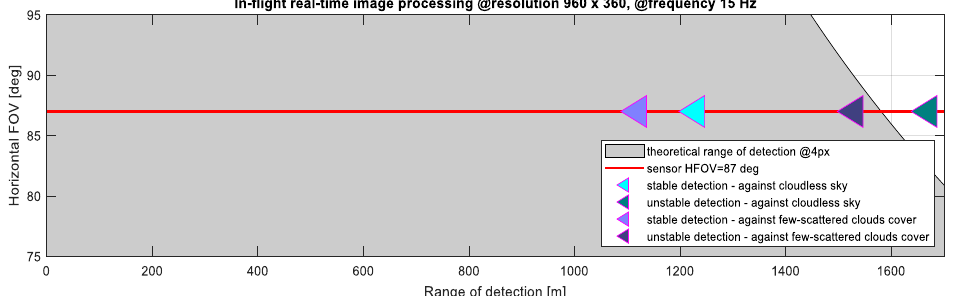
Figure 14. Qualitative analysis of the detection of an intruder with LDO = 10 m (results for image processing on board a flying plane, real time computations).